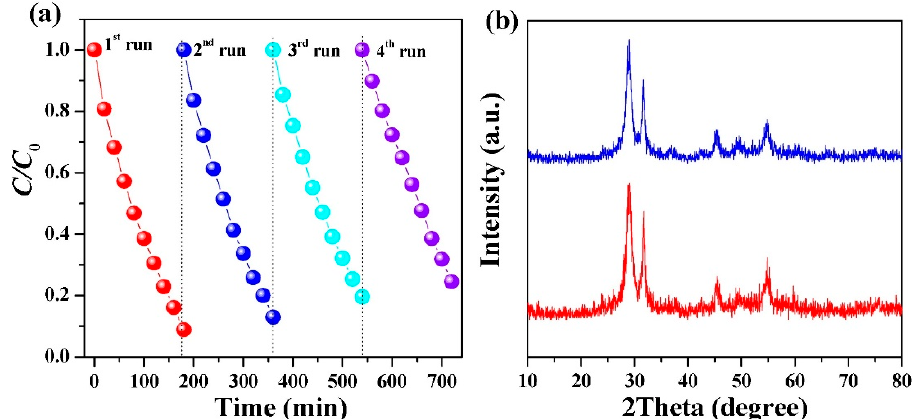
Figure 10. ( a ) Evaluation of recyclability of the catalyst via normalized zero-order degradation plot for resorcinol using recycled Bi 4 O 5 Br 0.6 I 1.4 . ( b ) XRD spectra of Bi 4 O 5 Br 0.6 I 1.4 .before (blue) and after (red) exposure to the visible light source and resorcinol solution [116]. Copyright 2018 Elsevier.